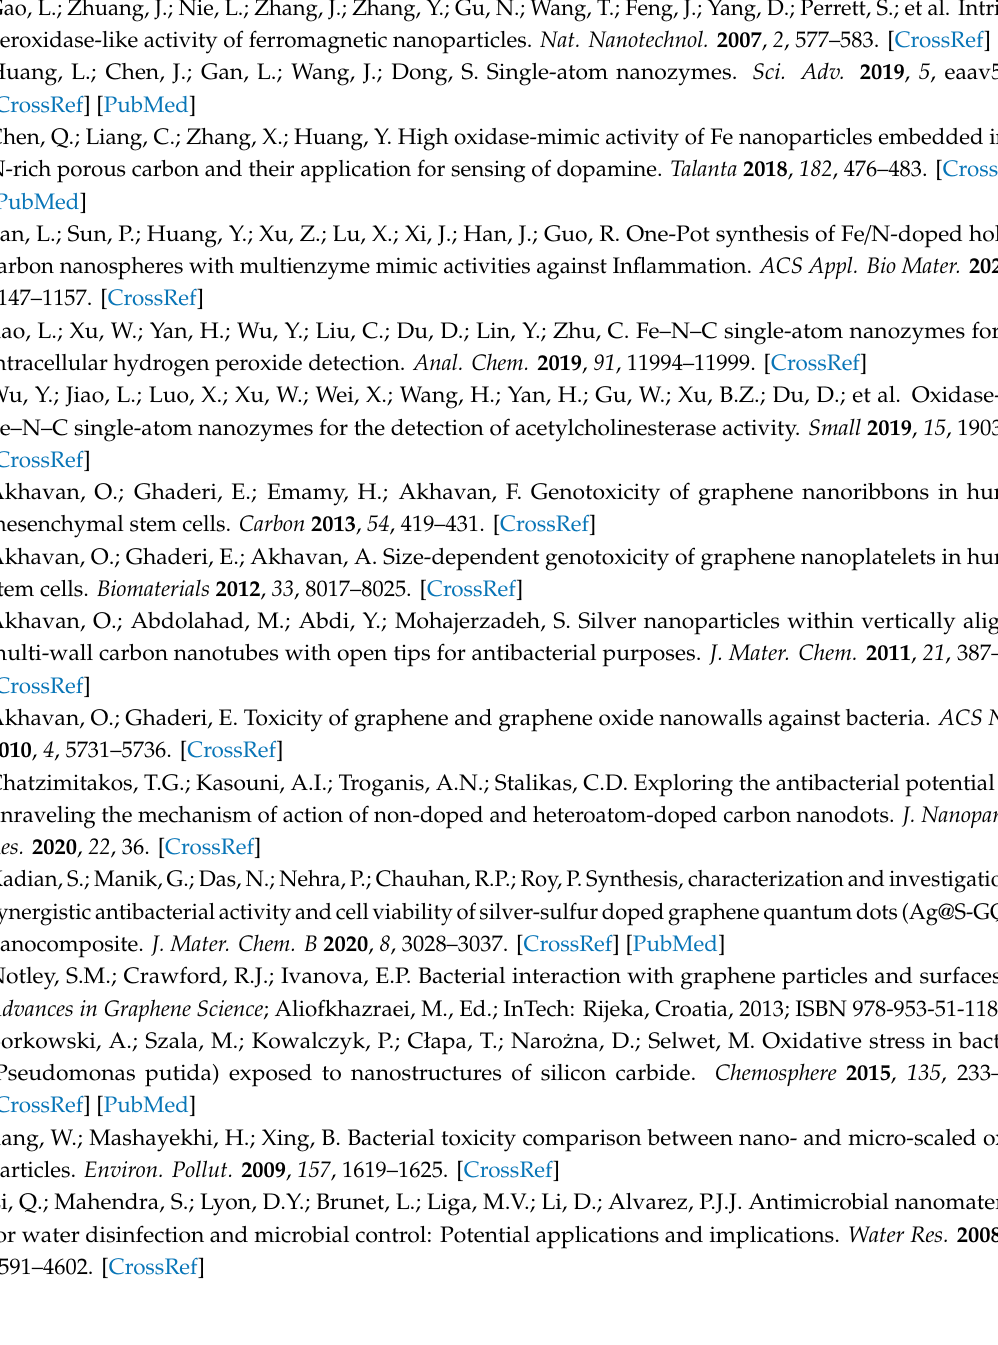
doped carbons, Figure S3: Adsorption isotherms of bacteria B. cereus on the doped carbons, Figure S4: The maximum sorption capacity of E. coli (a) and B. cereus (b) according to Langmuir isotherms, Table S1: The chemical composition (mg L − 1 ) of the aqueous suspensions of the studied